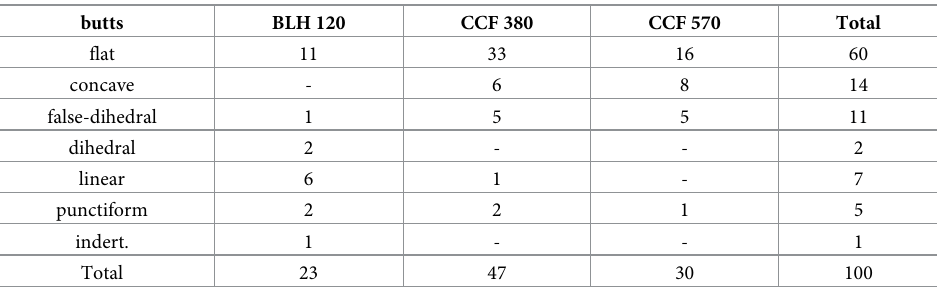
Table 3. Distribution of types of butt per house.